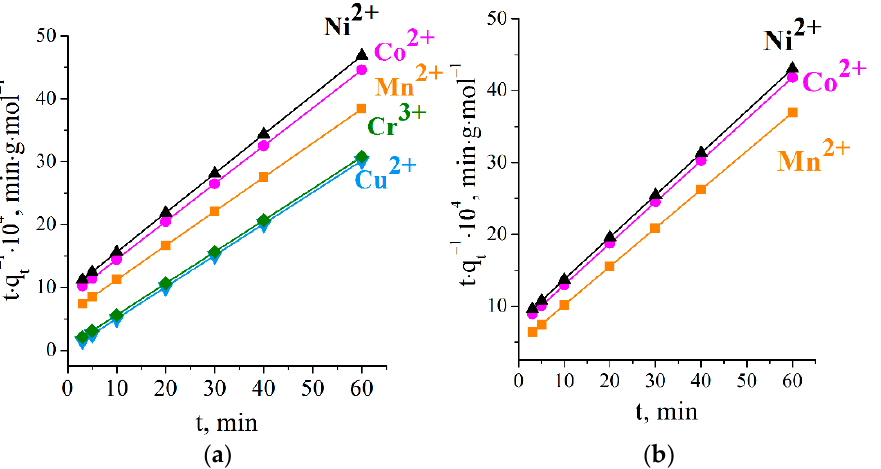
Figure 8. Pseudo-second-order kinetics plot for studied ions’ adsorption on titanium phosphate at 298 K ( a ) and 303 K ( b ).